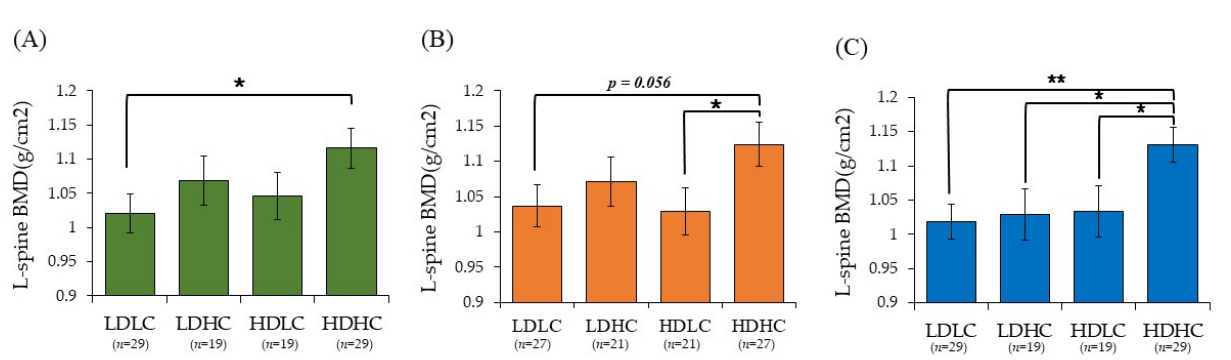
Figure 4. L-spine bone mineral density according to calcium and vitamin D intake. ( A ) Annual average; ( B ) Summertime; ( C ) Wintertime. Intake of vitamin D and calcium per 1000 kcal in the annual average, summertime, and wintertime was divided by the median value (Annual: vitamin D/1000 kcal: median, 7.11 µg; calcium/1000 kcal: median, 342.96 mg; Summertime: vitamin D/1000 kcal: median, 5.21 µg; calcium/1000 kcal: median, 342.48 mg; Wintertime: vitamin D/1000 kcal: median, 5.53 µg; calcium/1000 kcal: median, 353.22 mg). Covariates: YSM, BMI, NTX. The p -values were derived from ANCOVA. * p < 0.05, ** p < 0.01.